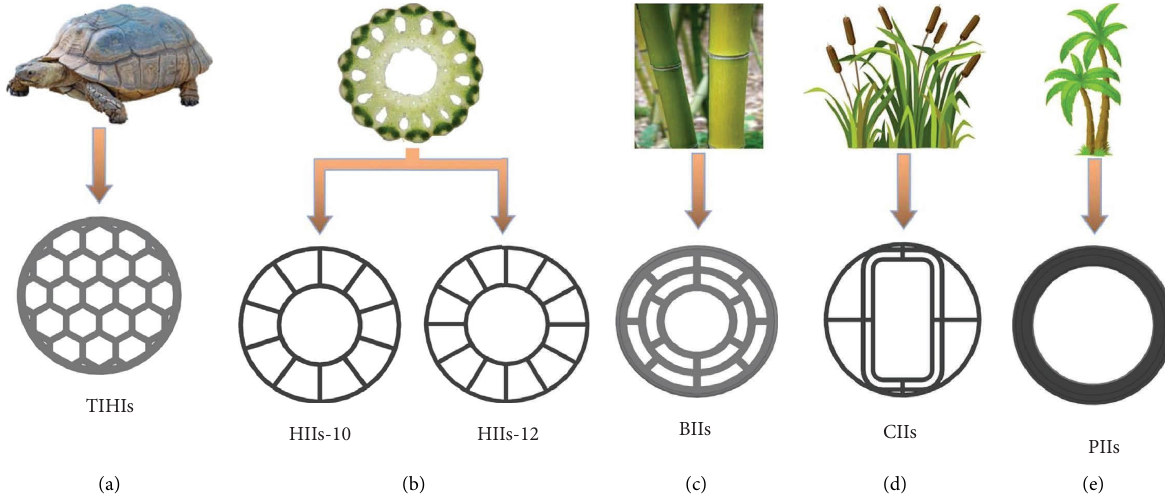
Figure 1: Te nature-inspired infll confguration: (a) TIHIs, (b) HIIs with ten branches (HIIs-10) and HIIs with twelve branches (HIIs-12), (c) BIIs, (d) CIIs, and (e) PIIs.